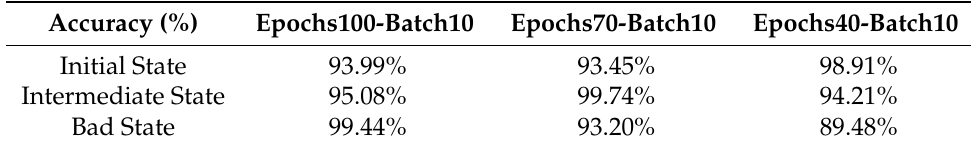
Table 7. Accuracy results from testing the implemented